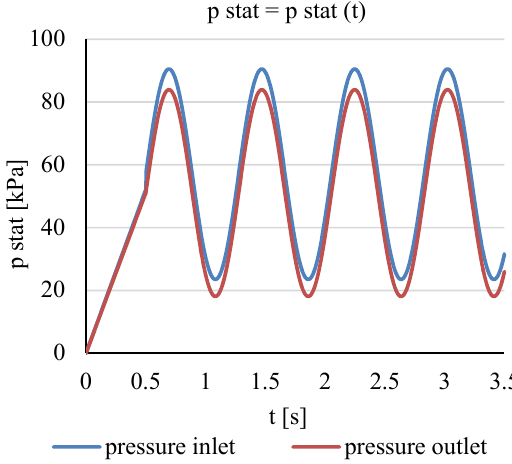
Fig. 1 Inlet and outlet pressures in the elastic and rigid pipe